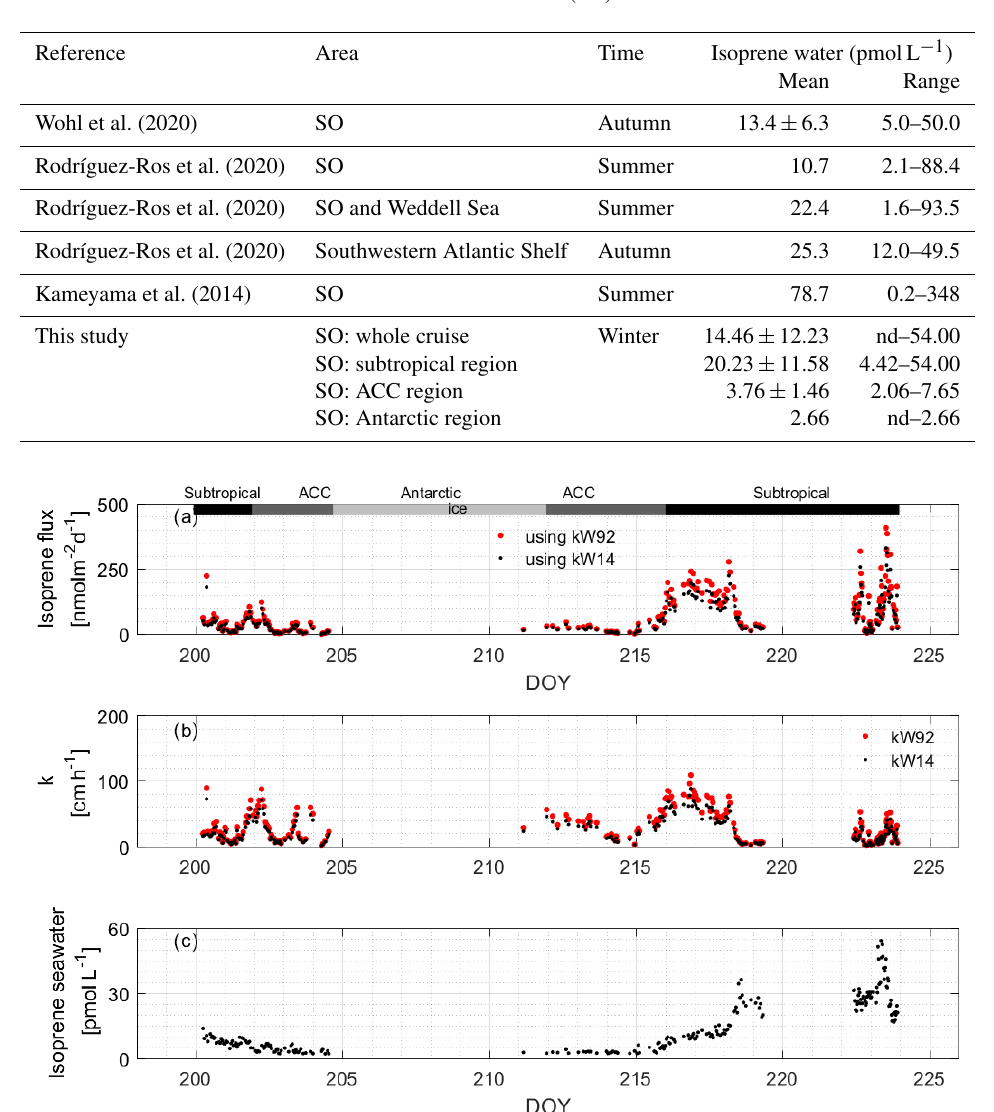
Figure 11. (a) Calculated isoprene fluxes using (b) two different k values. The measured water values that were used to compute the fluxes are shown in (c) . The bars across the top of the figure denote the different hydrographic regions discussed throughout the